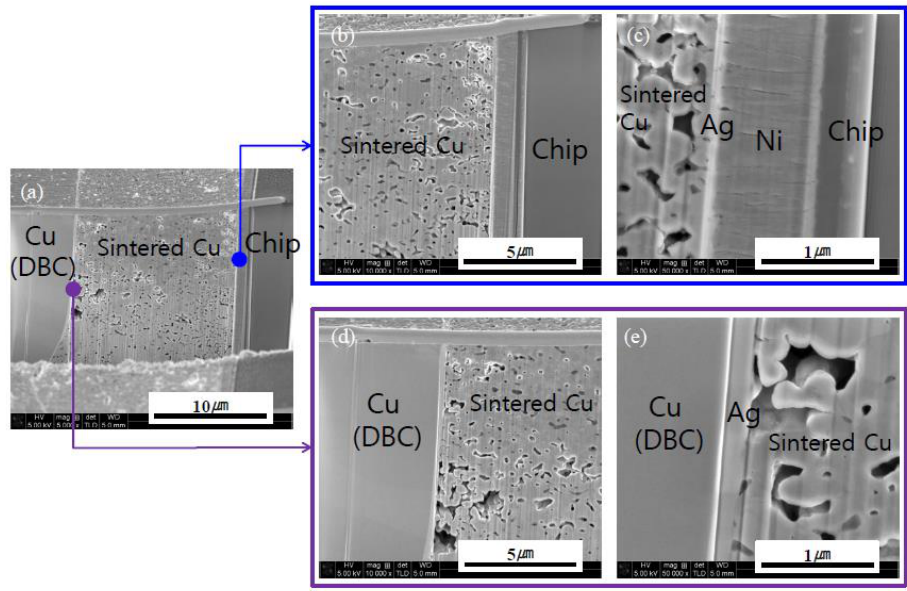
Figure 7. Cross-sectional FIB images of the Si chip/sintered Cu layer/DBC joint (sintering conditions: 300 °C, 10 MPa, 10 min).